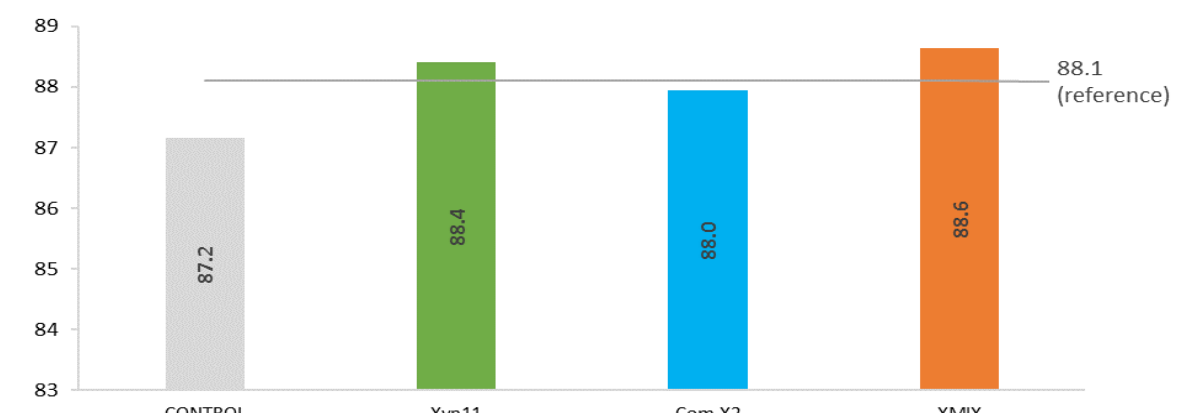
Figure 4. Final pulp brightness obtained after 5 h prebleaching stage with different xylanases fol- lowed by 15% less ClO 2 applied in each D step of the bleaching sequence.